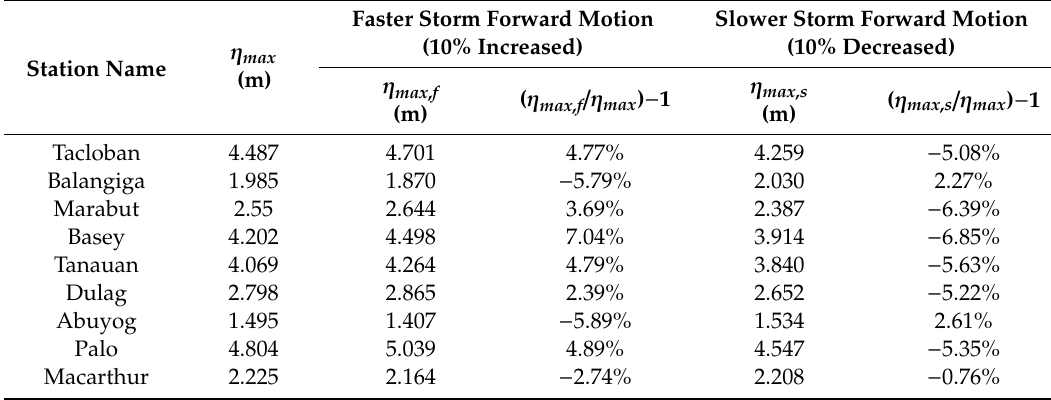
Table 4. Maximum computed storm surges in the numerical experiment using original, faster, slower storm forward